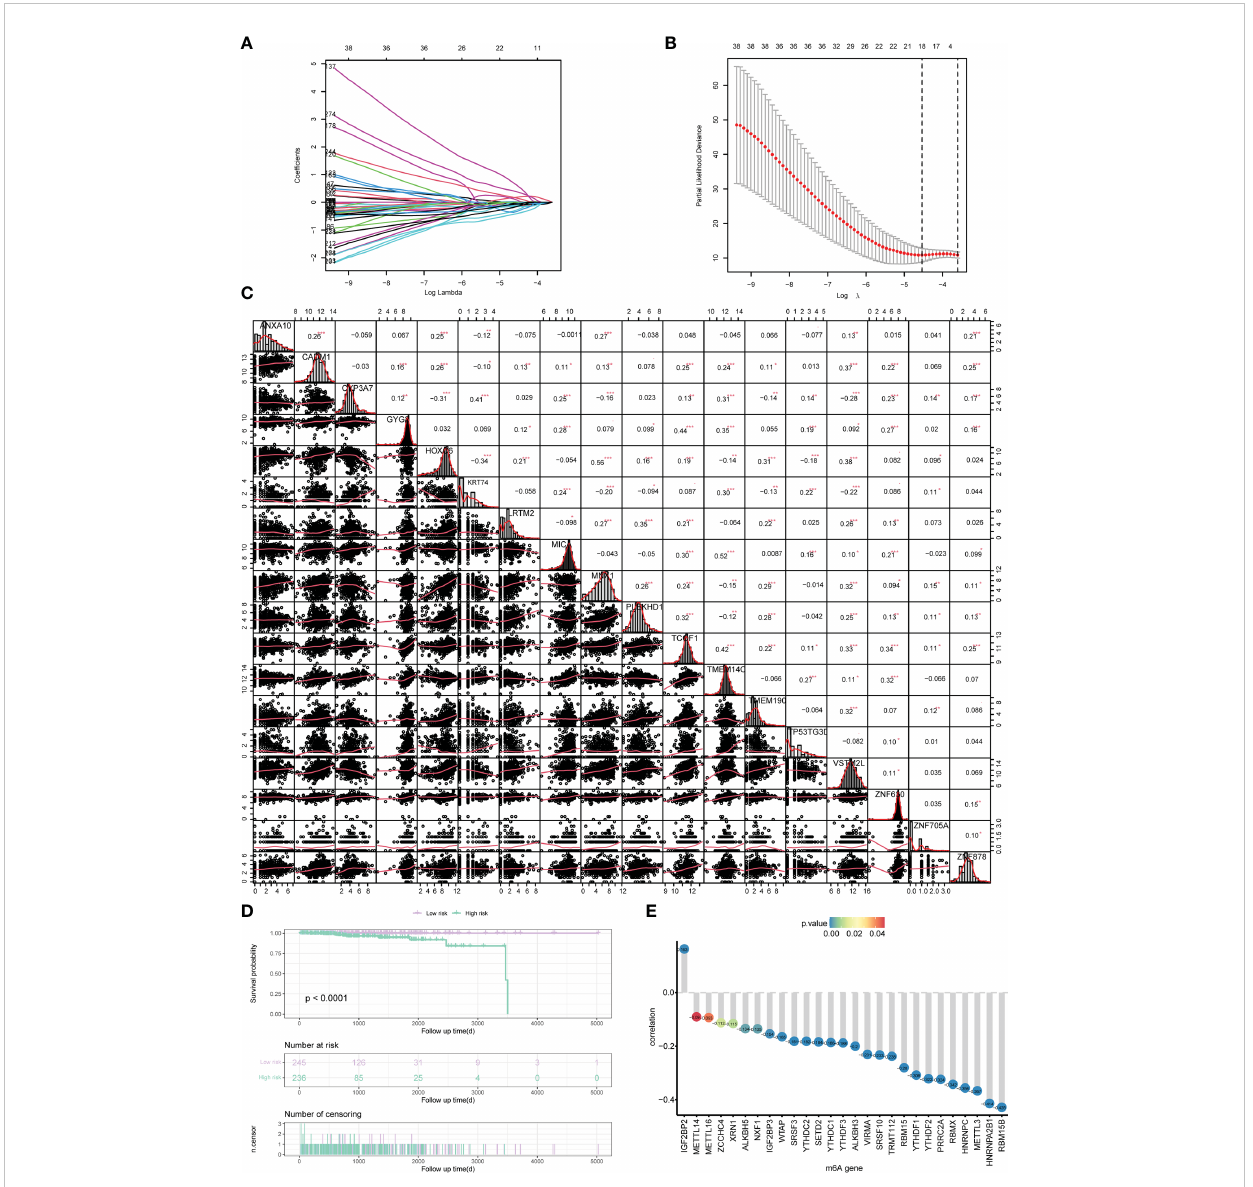
FIGURE 4 Construction of the risk scoring model. (A, B) LASSO Cox analysis identi fi ed 18 signature genes most associated with OS in the dataset of PRAD patients from TCGA. (C) Expression correlation analysis of signature genes in PRAD. (D) Kaplan-Meier curve assessed the effect of risk score on overall survival in PRAD patients, with patients with low risk in purple and patients with high risk in green. (E) The correlation analysis of m 6 A-related genes and risk scores. The horizontal axis shows m 6 A-related genes, the vertical axis shows the size of correlation, and the node color indicates the signi fi cance level. *P < 0.05, **P < 0.01, *** P <